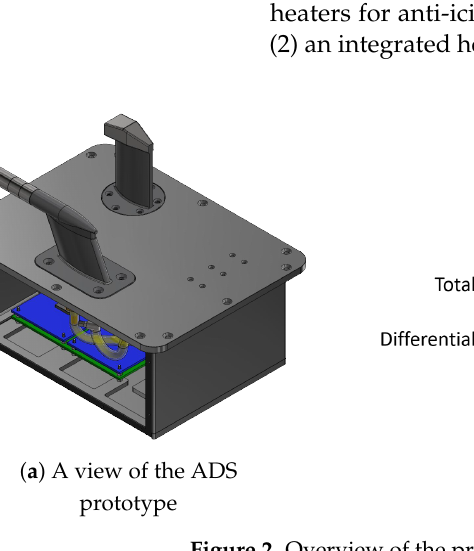
Figure 2. Overview of the proposed air data system (ADS): architecture and